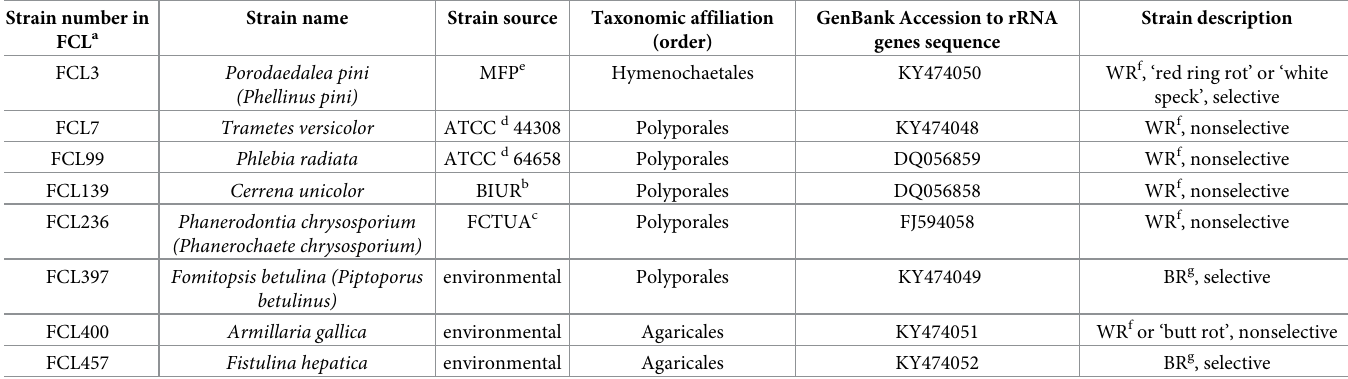
Table 1. Fungal strain used in this